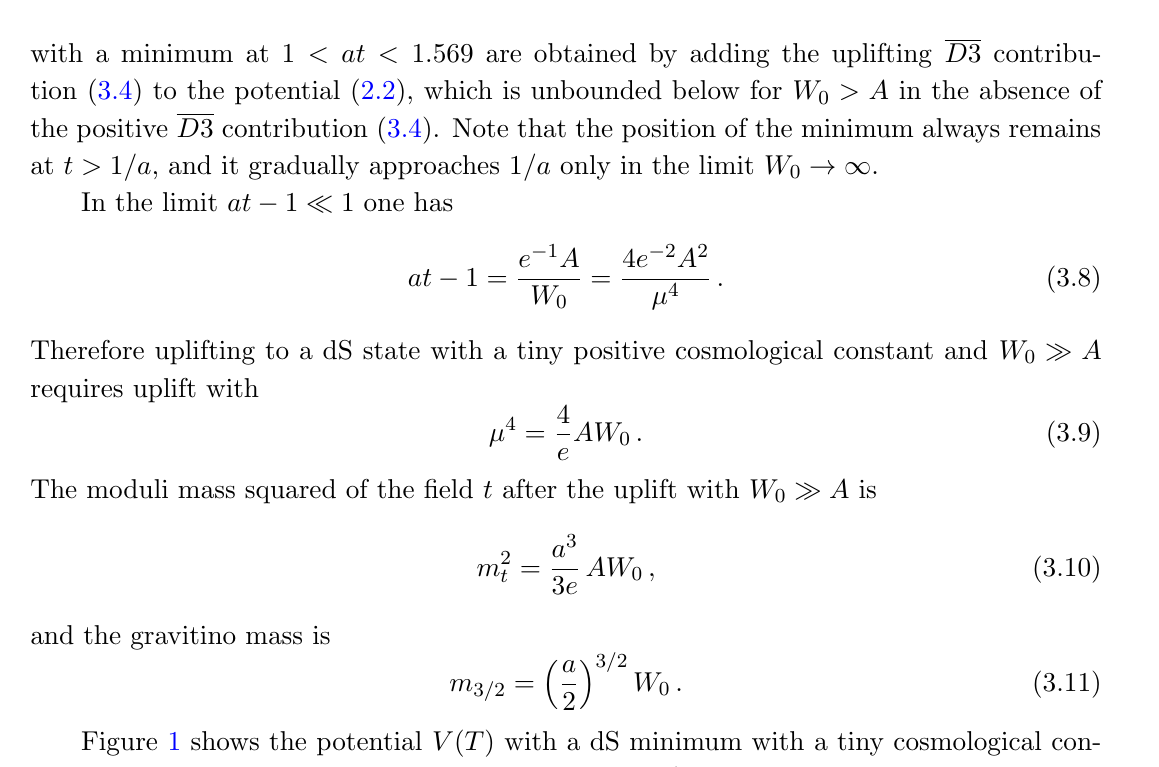
Figure 1 . KKLT potential (3.3) with a metastable dS vacuum at t (cid:25) 16, (cid:18) = 0. It was ob- tained by adding the D 3 contribution (3.4) with (cid:22) = 3 : 4786 to the potential (2.2) in the KKLT model (1.1), (1.2) with a = 2 (cid:25)= 100, A = 1, W 0 =